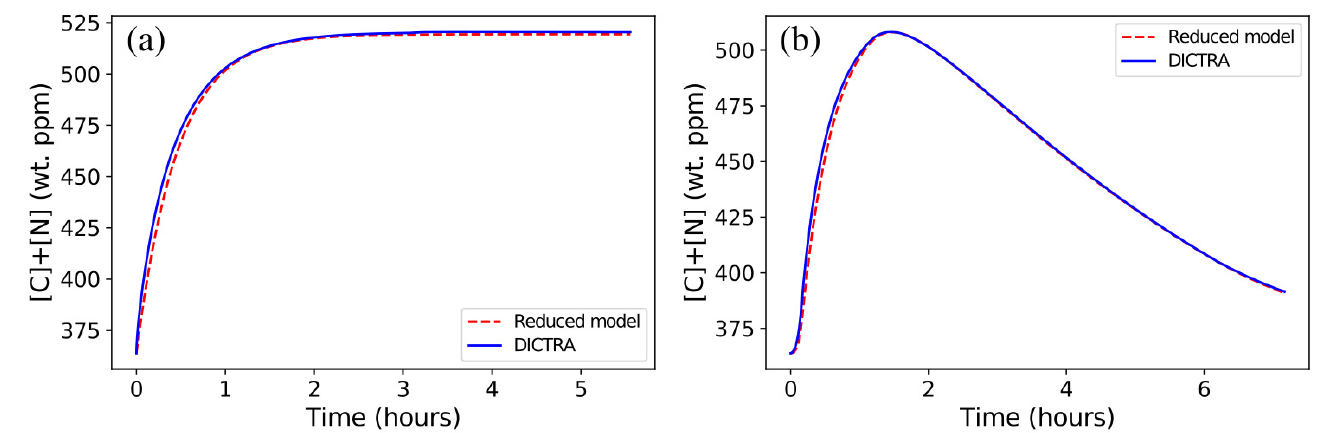
Figure 9. Comparison of the sum of the mean C and N contents in austenite ([C]+[N]) calculated using DICTRA (7-element calculation using TCFE9) and that obtained from corresponding reduced model for ( a ) isothermal holding at 1473 K and ( b ) the anisothermal 1473–1373